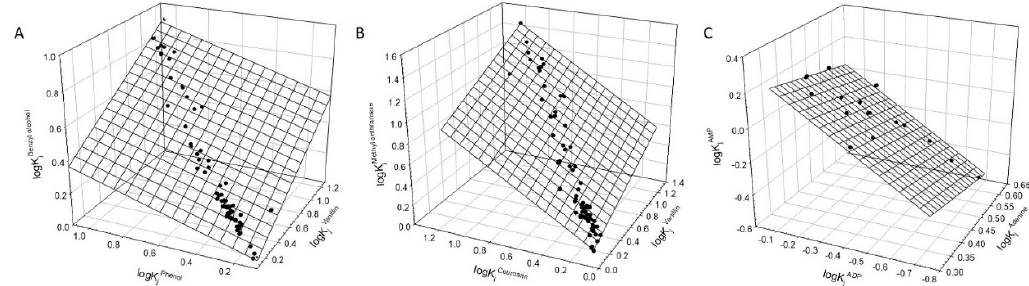
Figure 1. ( A ) Linear relationship between logarithms of partition coe ffi cients of vanillin, phenol, and benzyl alcohol in various aqueous two-phase systems (Data from Table S1, Supplementary Information). The plane corresponds to Equation (1). Error bars are the same size as / or smaller than the symbols. ( B ). Linear relationship between logarithms of partition coe ffi cients of vanillin, coumarin, and methyl anthranilate in various aqueous two-phase systems (Data from Table S1, Supplementary Information). The plane corresponds to Equation (1). Error bars are the same size as / or smaller than the symbols. ( C ). Linear relationship between logarithms of partition coe ffi cients of adenine, adenosine diphosphate (ADP), and adenosine monophosphate (AMP) in various aqueous two-phase systems (Data from Table S1, Supplementary Information). The plane corresponds to Equation (1). Error bars are the same size as / or smaller than the